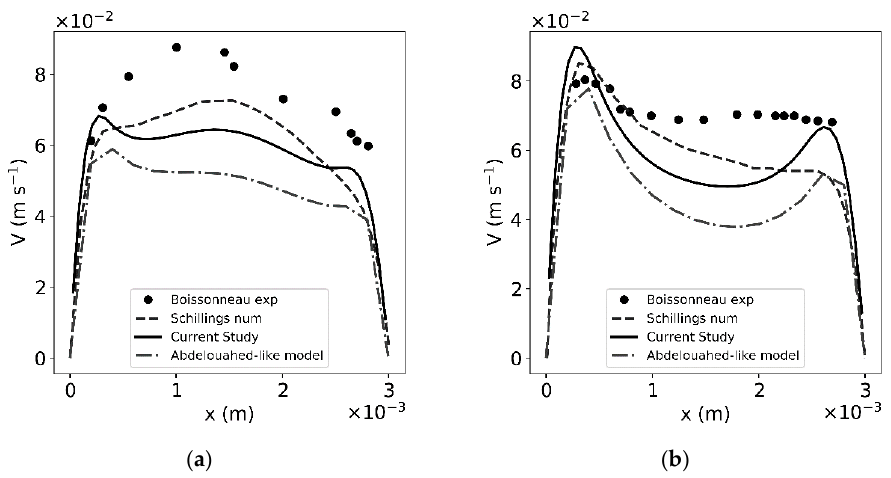
Figure 4. Results of the liquid velocity in different models at j = 1000 A m − 2 ( a ) at y = 60 mm and ( b ) at y = 75 mm. The dot are the data from Boissonneau et al. [15], the grey dashed line is the numerical results of the Schilling et al. model [14], the dotted and dashed line is a model using the method of Abdelouahed et al. [26]. Finally, the black solid line the results from the current study with 2D approximation.